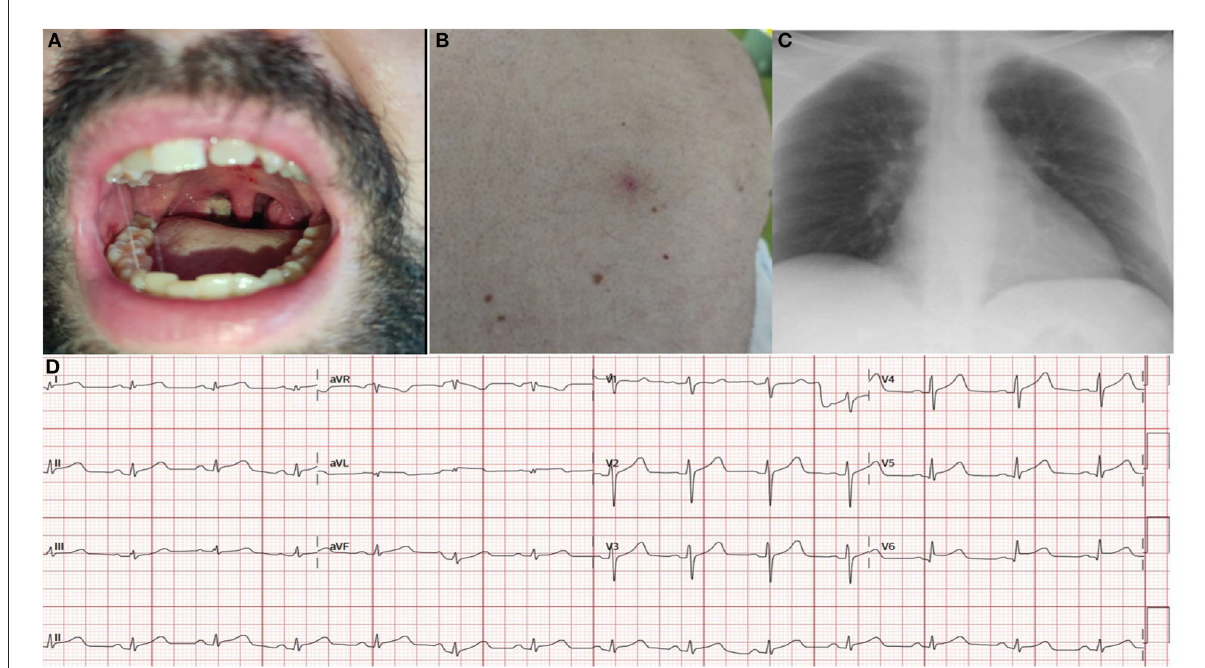
FIGURE1 Skin lesions (A, B) , chest x-ray (C) at admission and electrocardiogram at admission (D) . At admission, the electrocardiogram revealed sinus rhythm with diffuse ST elevation with upward concavity in leads (I, II, III, AVF, V4, V5, and V6) and diffuse depressed PR